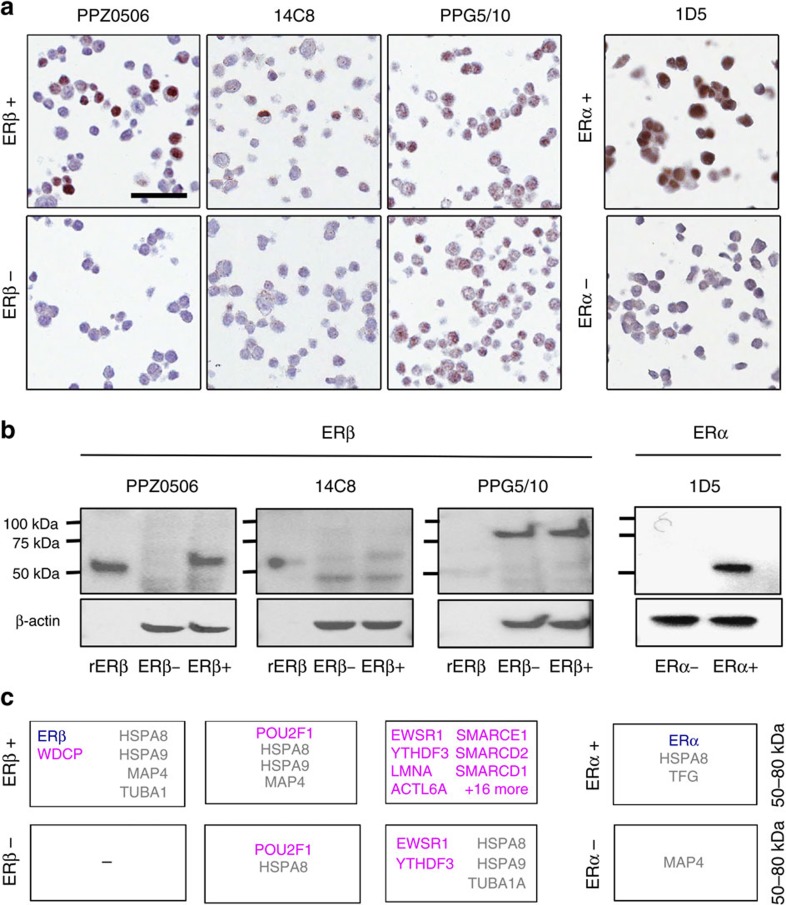
Validation of ERβ antibodies on positive and negative control cells.(a) Representative images of IHC staining pattern on control cells. Left panel: ERβ antibodies PPZ0506 (Invitrogen, dilution 1:250), 14C8 (GeneTex, 1:1,500) and PPG5/10 (DAKO, 1:60) on ERβ-positive (HCT116-ERβ, top) and ERβ-negative (HCT116-Mock, bottom) control cells. Right panel: ERα antibody 1D5 (DAKO, 1:150) on ERα-positive (T47D-Mock, top) and ERα-negative (HCT116-Mock, bottom) control cells. Scale bar in top left image indicates 50 μm. (b) Representative images of western blotting on control cells. Left panels: Indicated ERβ antibodies (dilution 1:1,000, except for PPG5/10 which is 1:200) on recombinant ERβ (rERβ), ERβ-negative cell lysate (HCT116-Mock), and ERβ-positive cell lysate (HCT116-ERβ), performed on the same cell lysates run one gel on consecutive lanes. Right panel: ERα antibody 1D5 (1:1,000) on ERα-negative (HCT116-Mock) and ERα-positive (T47D-Mock) control cells. Lower panels show loading control (beta-actin). (c) Summary of proteins detected by MS in IPs of the respective antibodies in 50–80 kDa gel bands in replicated experiments. Blue font indicates expected antibody-targeted protein, purple non-intended targets, and grey proposed general binders.